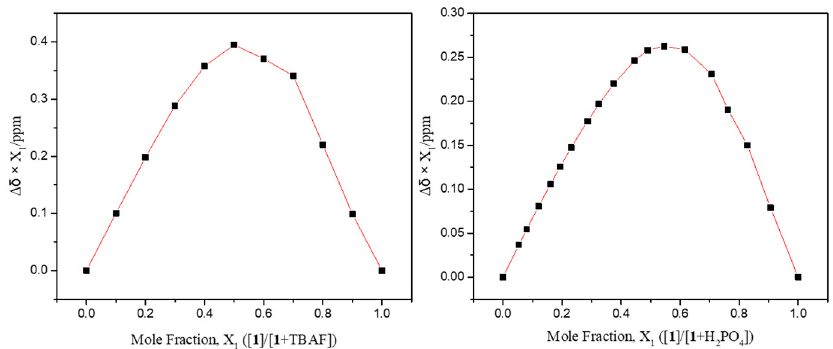
Figure 7. Job’s plots for the interaction of receptor 1 with TBAF (left) and TBAH 2 PO 4 (right), respectively, in CD 3 CN.